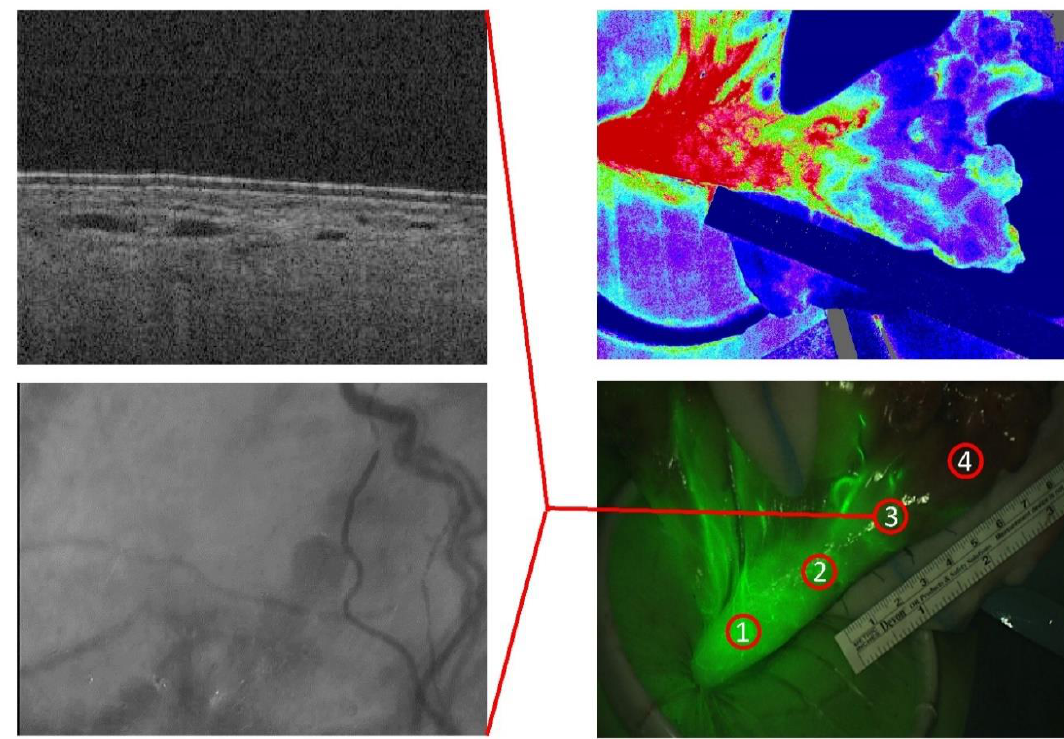
Figure 1. Qualitative images by all four imaging techniques: upper left Optical Coherence Tomography (OCT), lower left Sidestream Darkfield Imaging (SDF), upper right Laser Speckle Contrast Imaging (LSCI), and lower right Fluorescence Angiography (FA). Perfusion measurements were performed at four locations (Loc1–4): 3 cm proximal of the level of (Loc1), at the level of (Loc2), 3 cm distal to (Loc3) the level of the watershed between the right and left gastroepiploic artery, and at the level of the gastric fundus (Loc4).